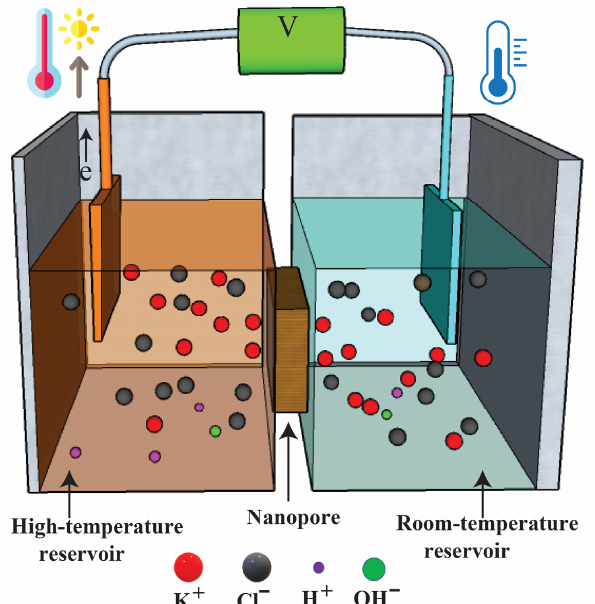
Figure 1. Illustration of thermal-osmotic generation using nanopore membrane.